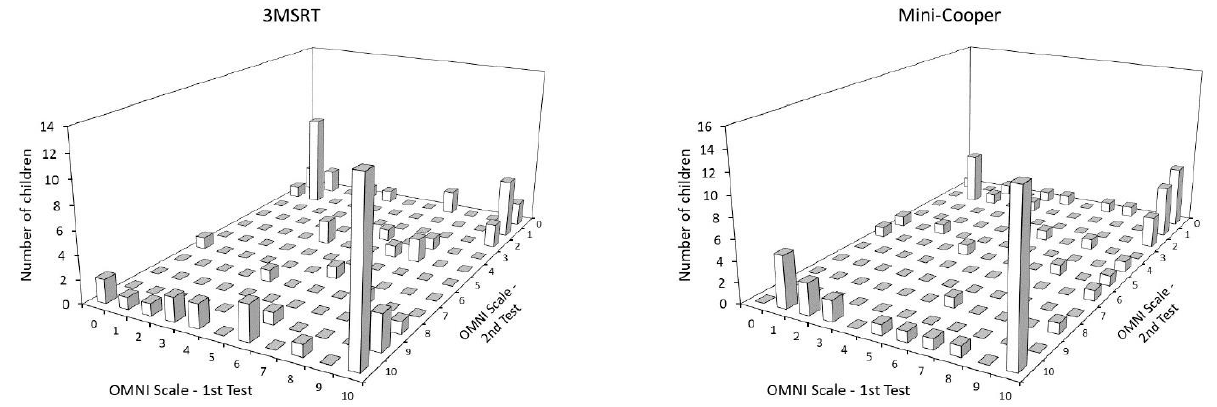
Figure 3. Comparison of the results of the test and retest of the 3MSRT and Mini-Cooper.